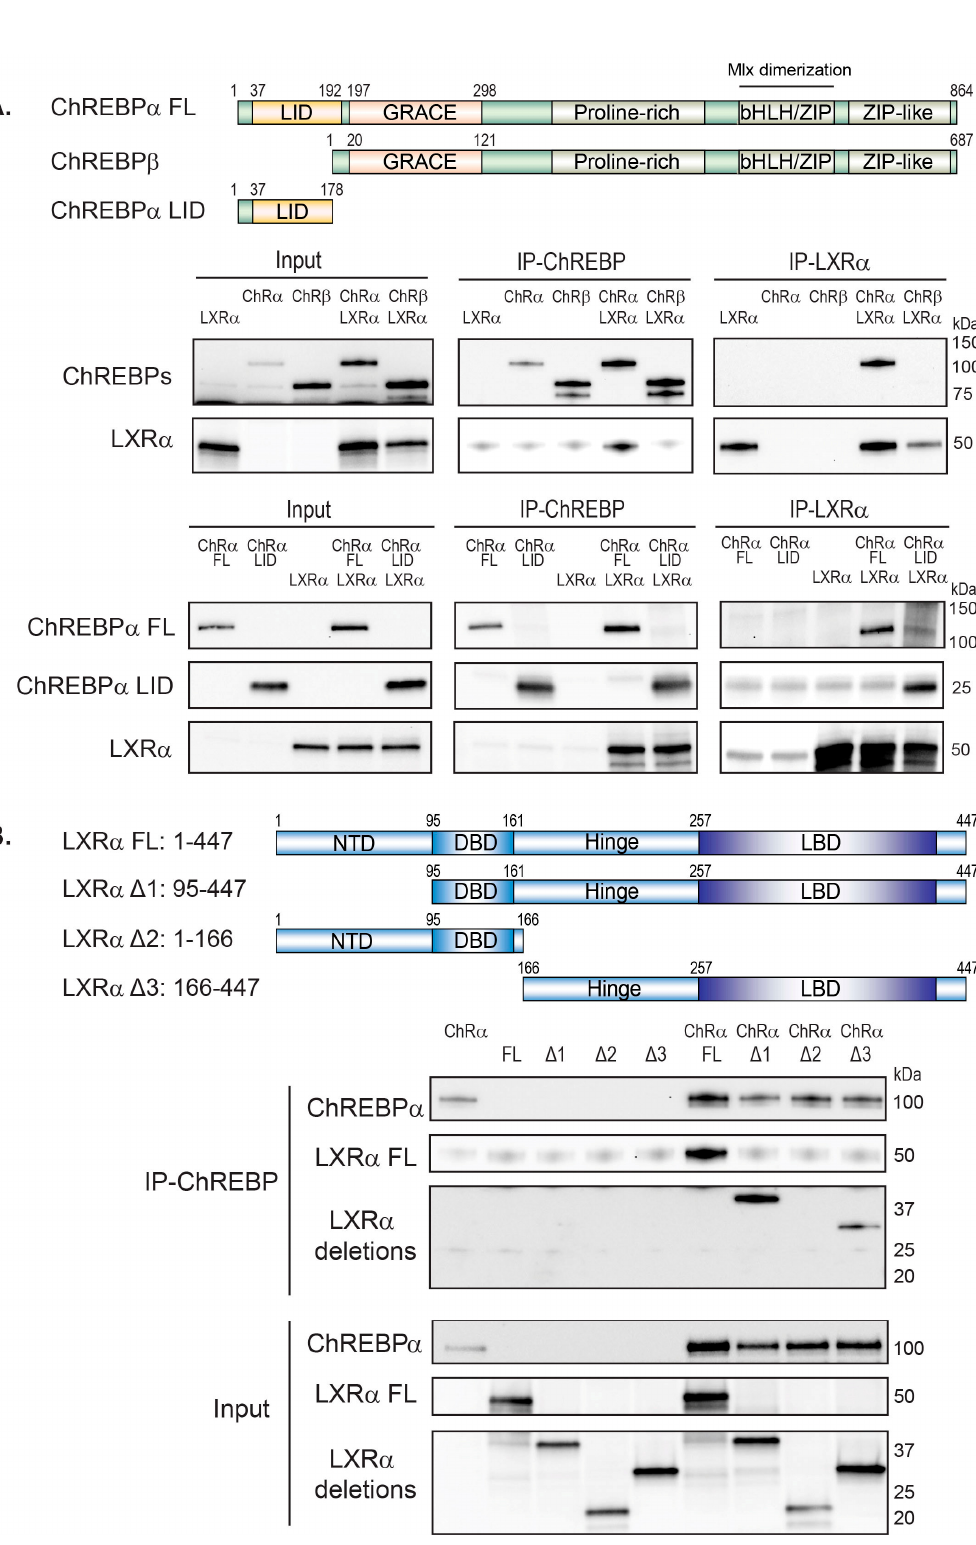
Figure 4. LXR α and ChREBP α interact via key activation domains. ( A ). Top panel: Schematic representation of the ChREBP α full-length (FL), ChREBP β and the low glucose inhibitory domain (LID) protein. Bottom panel: CoIP of LXR α and ChREBP α , ChREBP β or LID, expressed in COS-1 cells cultured in 25 mM glucose. The ChREBP expression plasmids were transfected with a DNA ratio of ChREBP α :ChREBP β :LID = 1:6:1, to obtain comparable protein levels. Lysates were immunoprecipitated with ChREBP, FLAG (for LID) or LXR α antibodies and input and immunoprecipitated proteins immunoblotted with the same antibodies ( n = 3). One representative